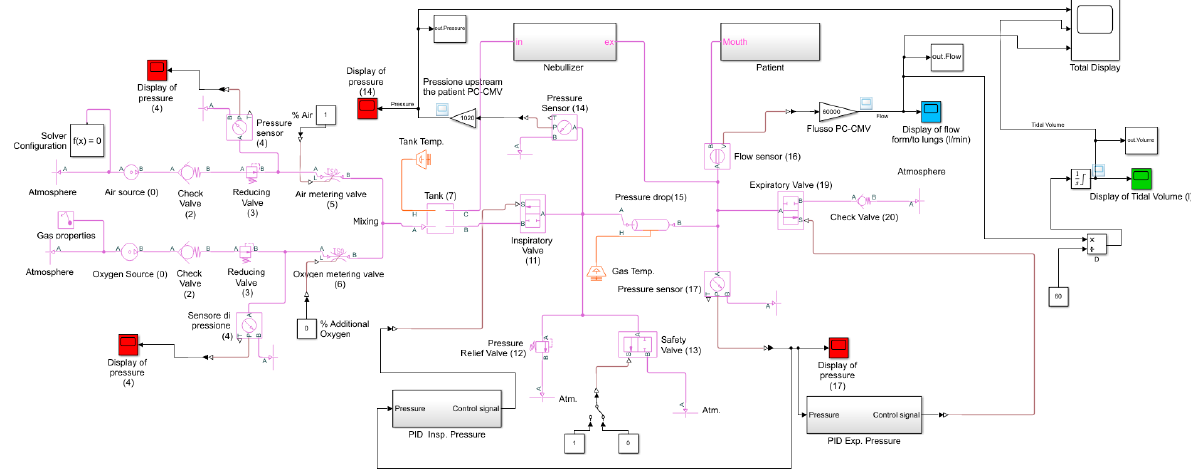
Figure 18. PC − CMV simulation code produced with Simulink (Simscape Fluids (gas) library). Figure 18. PC-CMV simulation code produced with Simulink (Simscape Fluids (gas) The subroutine reproducing the automatic control of the inspiratory pressure is shown in Figure 19.